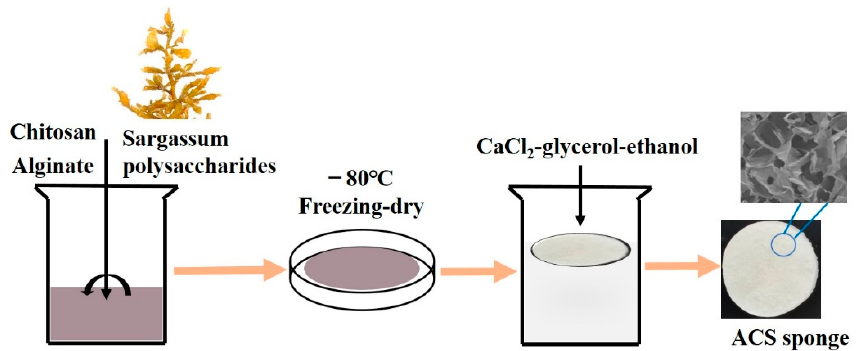
Figure 1. The schematic of the sponge synthesis method.